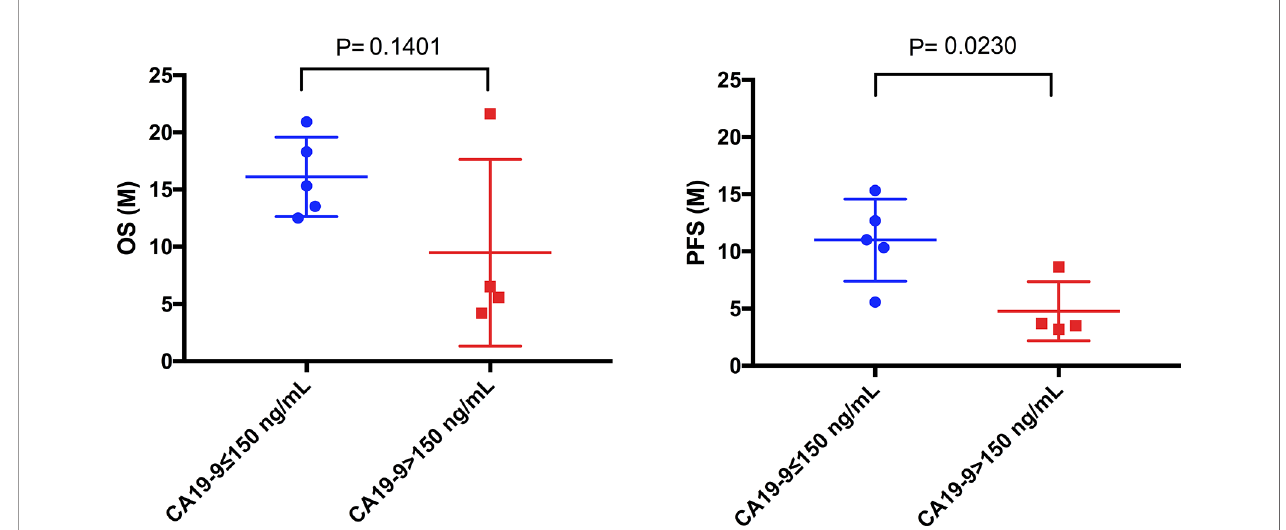
FIGURE 7 | ComparisonofmOSandmPFS betweenthelowCA19-9 andhighCA19-9groupsinICCpatients.ThemPFSofthelow CA19-9groupwas signi fi cantlylonger thanthatofthehighCA19-9group(10.78months vs. 4.76months,P =0.0230), buttherewas nosigni fi cantdifferenceinmOS(16.12monthsvs.9.48months,P